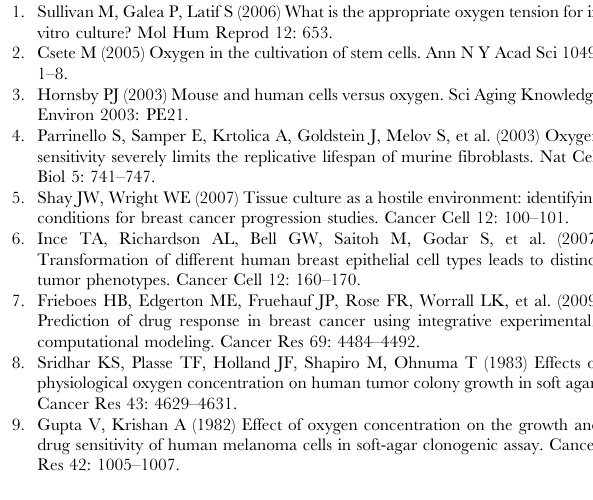
Table S3 Raw data from OVSS2 RPPA for Phospho